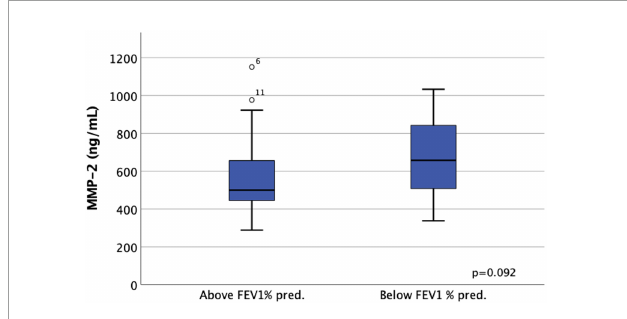
FIGURE5 Classification of lymphangioleiomyomatosis (LAM) patients based on median FEV1% pred. higher or lower than